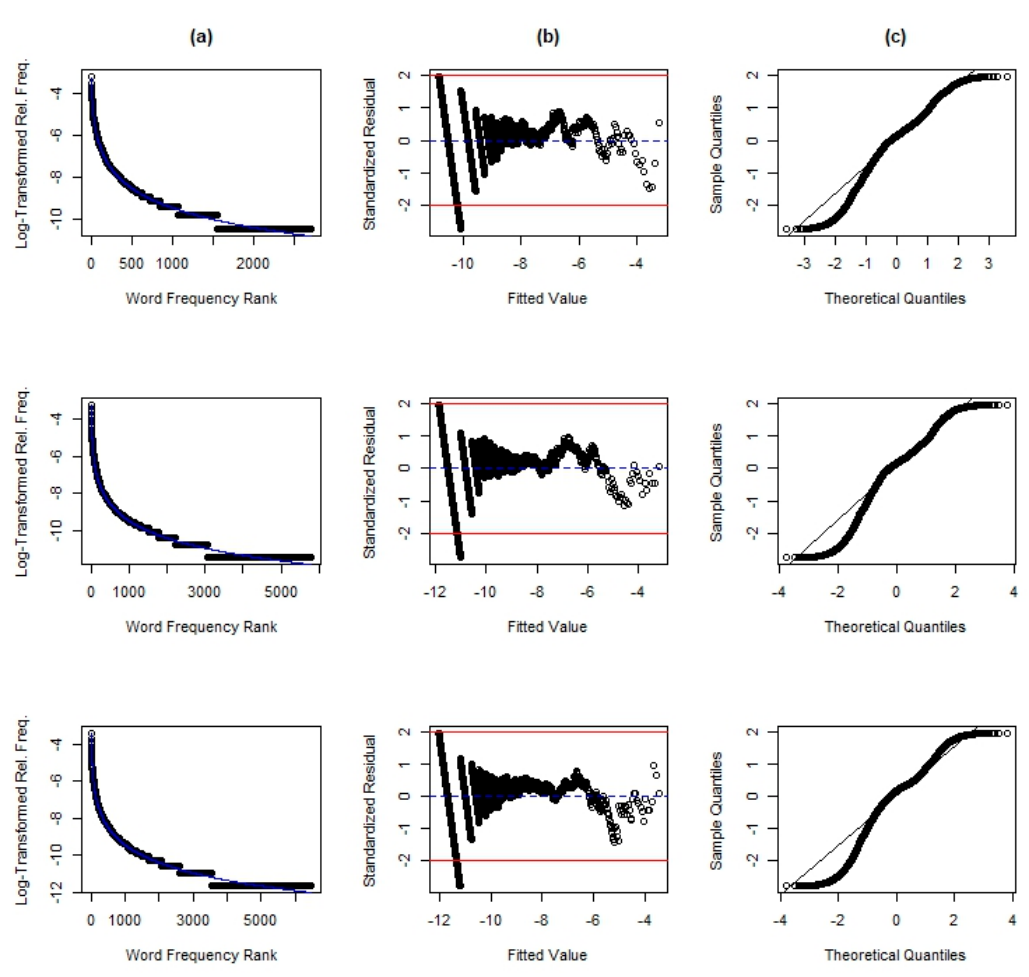
Figure 3. Analyzing ENDE Youth, ENDE Workers, and ENDE Retirees corpora fit to Mandelbrot’s Law. Each row corresponds to those corpora respectively. ( a – c ) as described for Figure 1. The theoretical quantile range is notably smaller for youths, but that is most likely due to the much smaller subcorpus size.